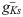
Slow potassium conductance and E/I balance work in concert to shape upstate traveling bump dynamics.The strength of inhibition determines the spatial scope of an active zone, or the space a traveling bump will traverse in a given time (the dx shown in blue above). The length of an upstate at any given point in space is governed by the strength of the slow potassium conductance gKs¯ (illustrated by the red dt above). These two features form the rough approximation of wavespeed dx/dt. As in Fig 2., black markers represent spikes from excitatory cells, red markers represent those from inhibitory cells and cells are sorted along the y-axis by spatial coordinate.